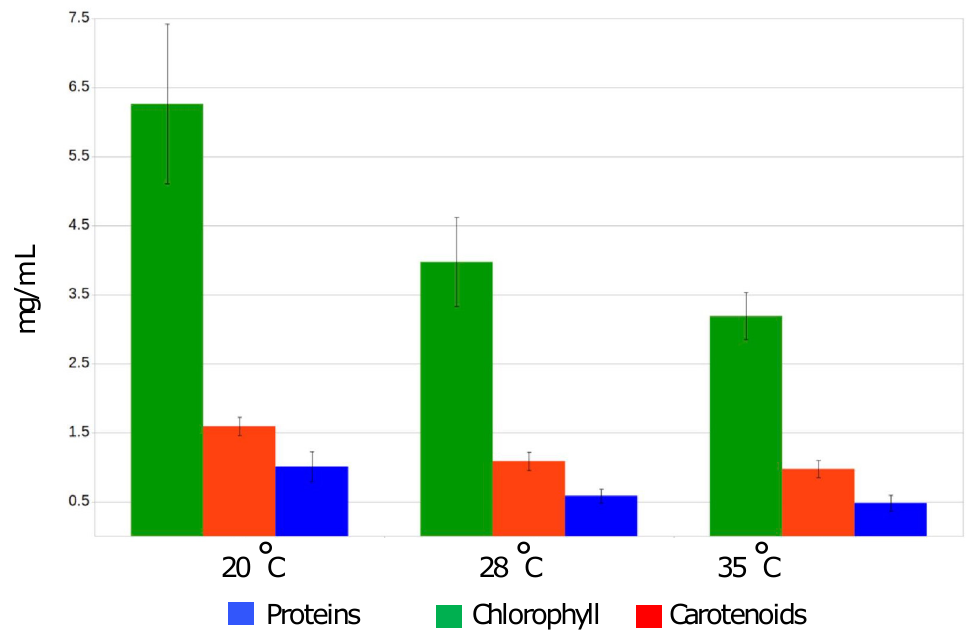
Figure 4. Quantity of chlorophyll, total carotenoids and proteins [mg/mL] extracted from biomass of Arthrospira sp. O9.13F cultivated at three different temperatures, 20 °C, 28 °C and 35 °C in Zarrouk medium with a total salinity 25 g/L. Standard deviations based on three replicate analyses are